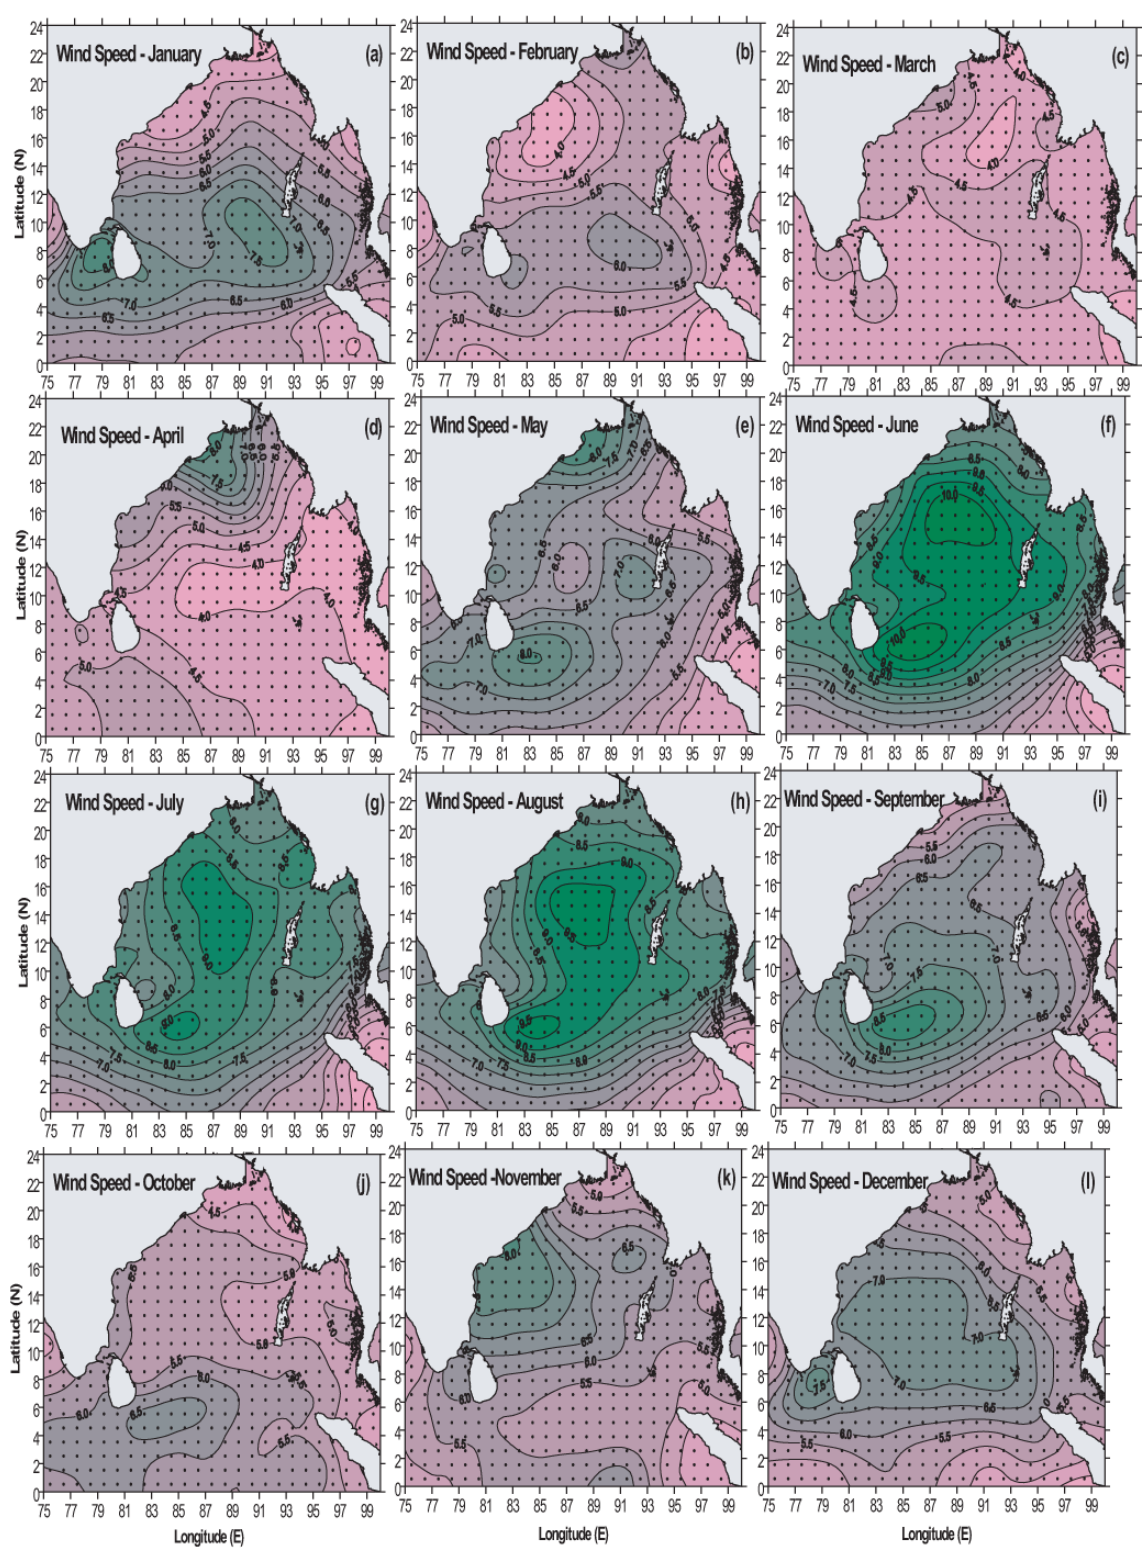
Figure A6. Monthly mean climatology of wind speed (WS, ms − 1 ) from January to